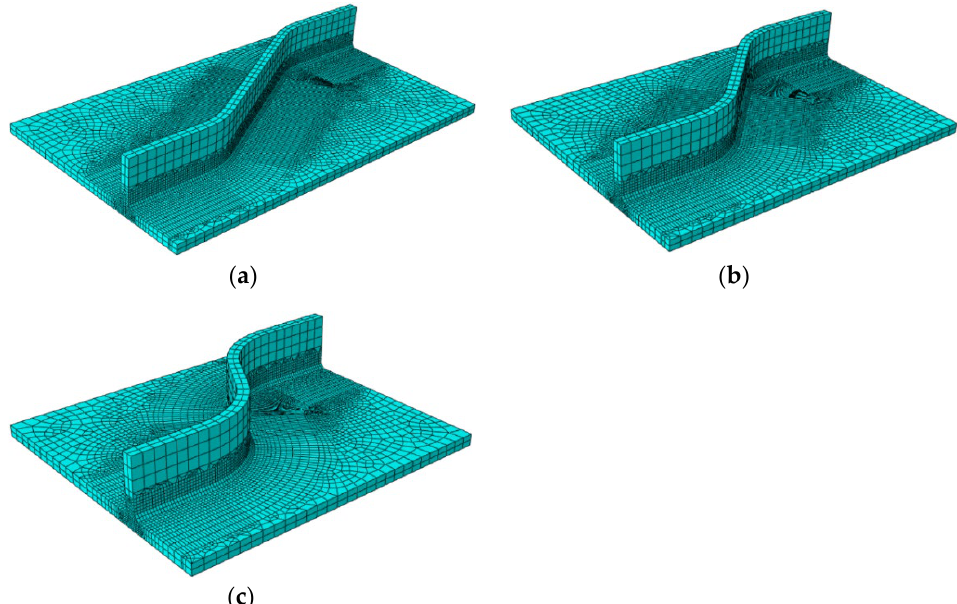
Figure 5. Meshing and boundary conditions model of CSWs. ( a ) Corrugated angle 30°; ( b ) Corrugated angle 45°; ( c ) Corrugated angle 60°.